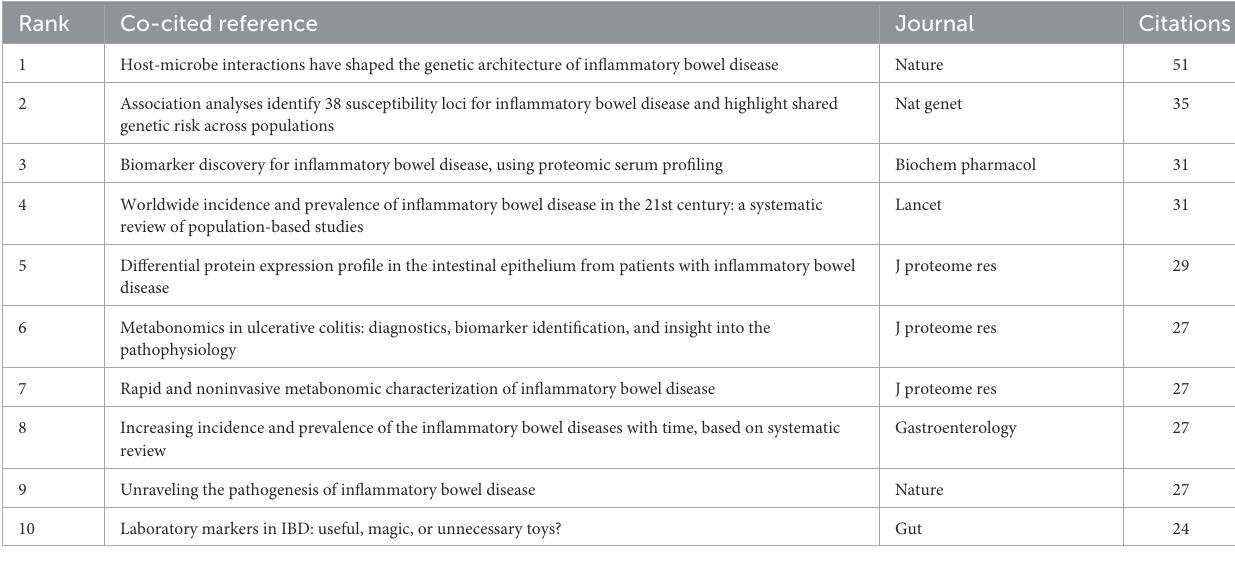
TABLE 4 The top 10 co-cited references on the research of omics in UC.